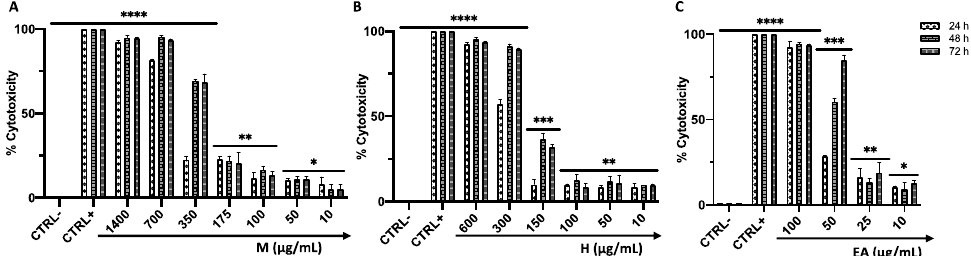
Figure 1. Cytotoxic effects (%) of M ( A ), H ( B ), and EA ( C ) in VERO CCL-81 cells after 24, 48, and 72 h of treatment. The data represent the mean ± standard deviation (SD) of three independent experiments. ****: p -value < 0.0001; ***: p -value < 0.0003; **: p -value < 0.008; *: p -value < 0.03.